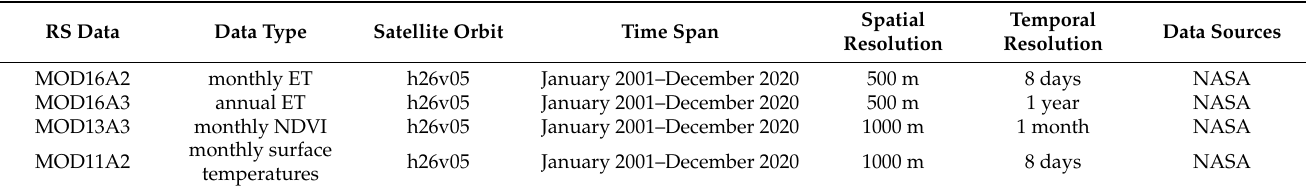
Table 1. MODIS products used in this